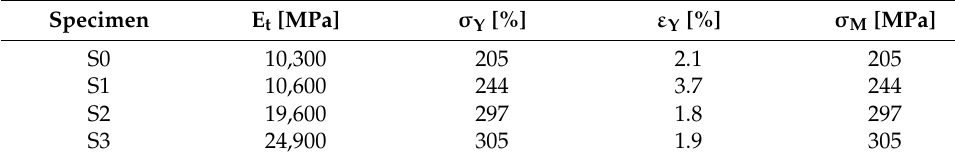
Table 10. Results of tensile tests.